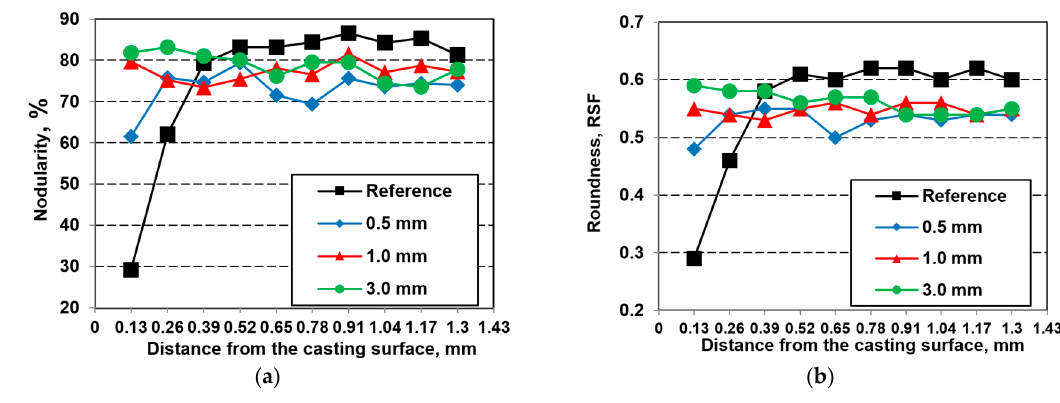
Figure 11. Influence of the steel sheet thickness on the graphite nodularity ( a ) and graphite roundness shape factor ( b ) at different distances from the casting surface (see Figure 2c).